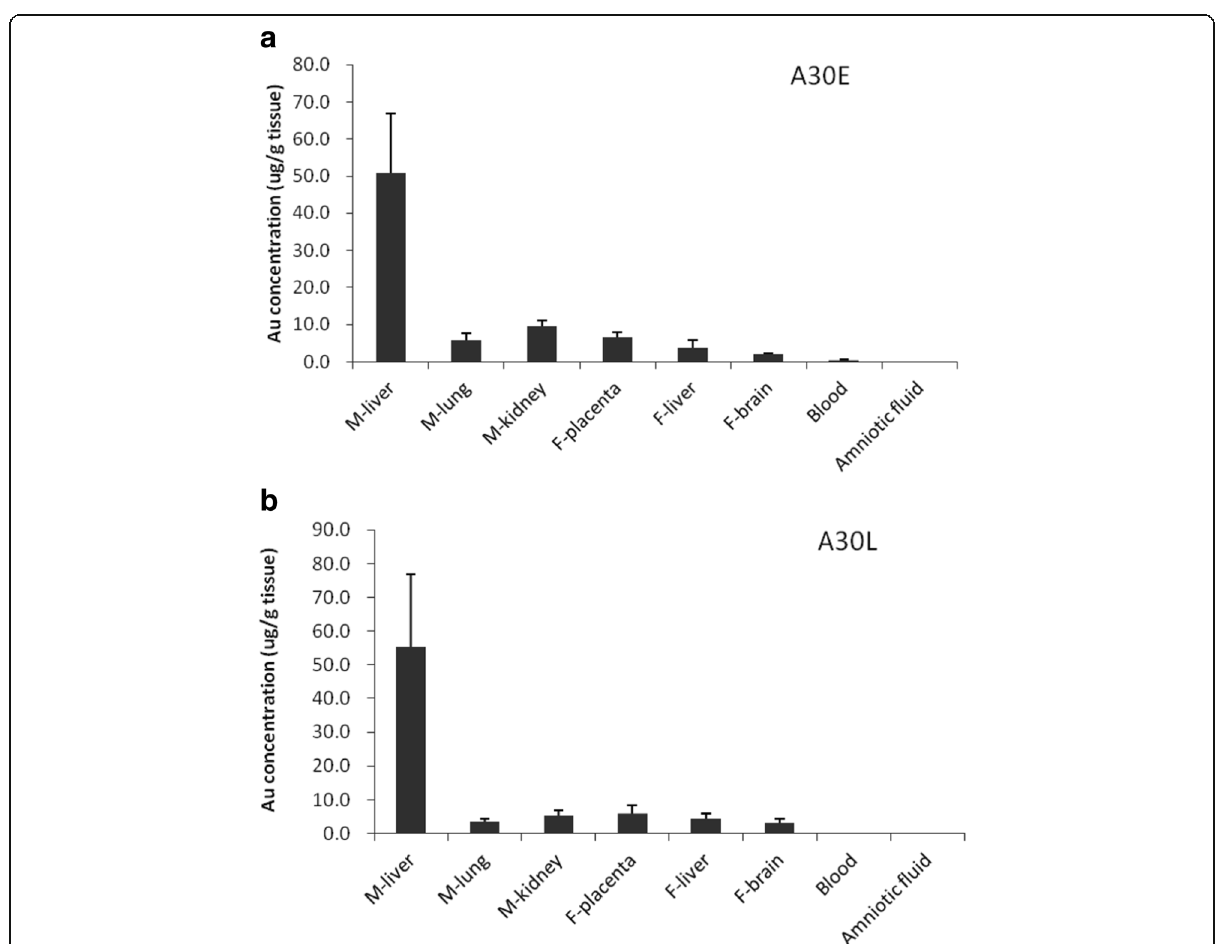
Fig. 6 Biological distribution of A30 in pregnant mice and fetuses. a Gold concentrations in maternal tissues, fetal tissues, blood and amniotic fluid of A30E group. b Gold concentrations in maternal tissues, fetal tissues, blood and amniotic fluid of A30L group. The collected tissues were weighed and digested in aqua fortis, and gold content assays were performed using an ELAN DRC-e ICP-MS instrument (Perkin Elmer, USA). Data are shown as mean ± s .d. ( n = 6 per group). M-organ, maternal tissue; F-organ; fetal